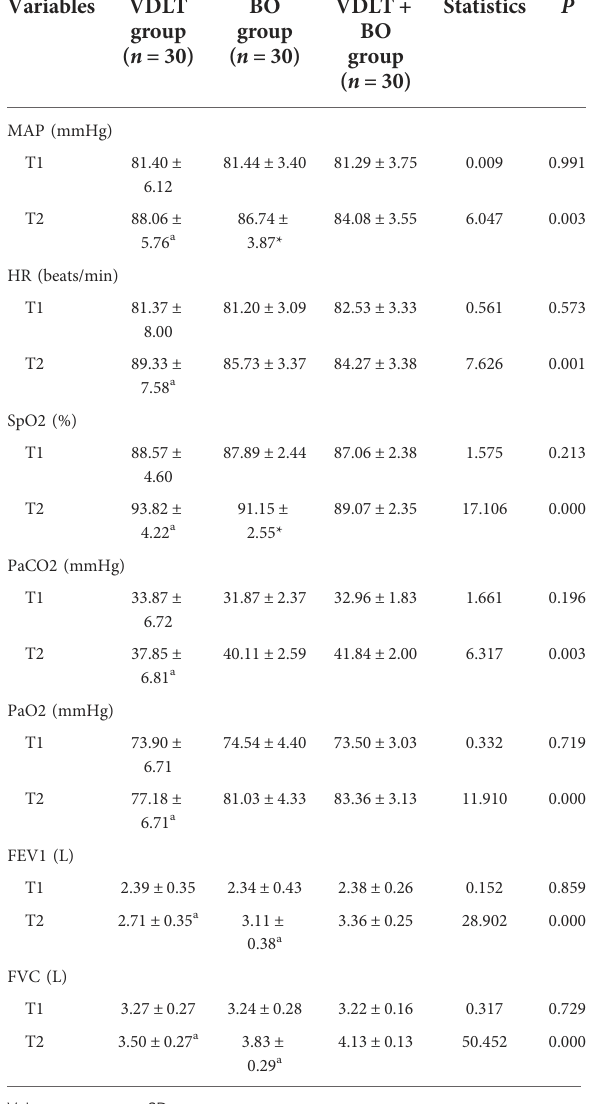
TABLE 3 Comparison of the success rate of intubation for different airway classes.